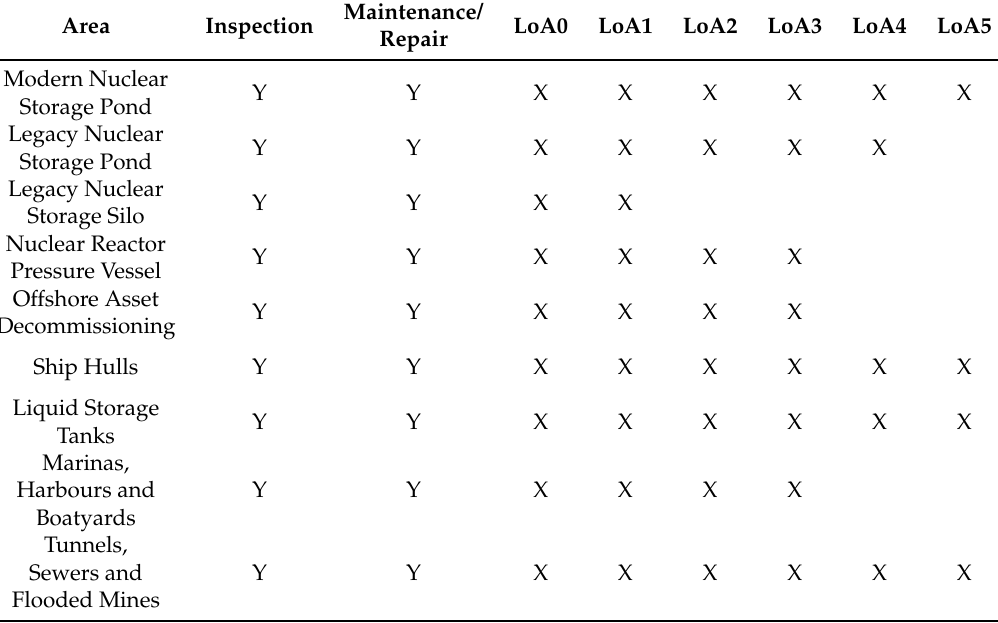
Table 3. Predicted Mission Types and Levels of Autonomy for Different